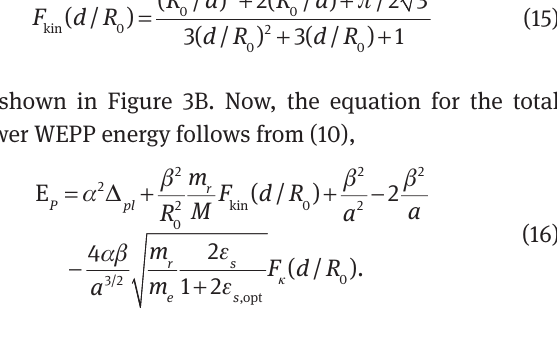
Figure 3: Dependences of (A) the overlap between the exciton and plasmon F of the polariton shell d/R